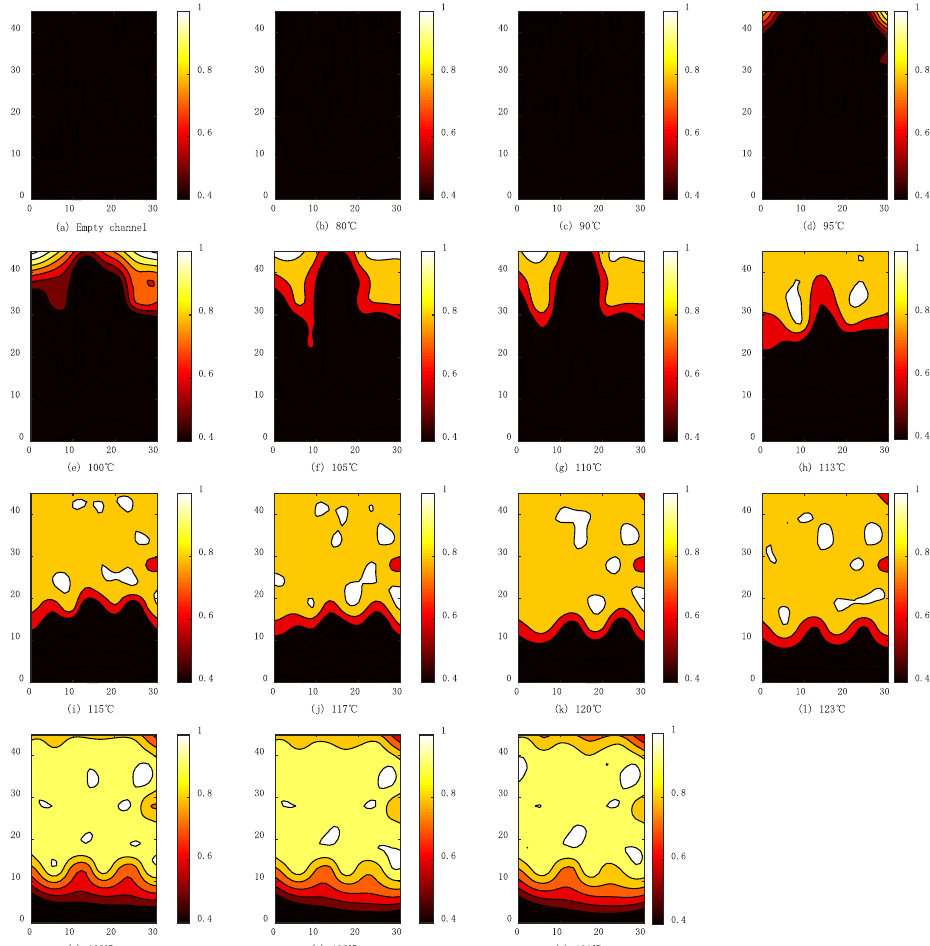
Figure 13. Visualization of the flow boiling in PFHE with different heating temperatures: ( a ) Empty channel; ( b ) 80; ( c ) 90; ( d ) 95; ( e ) 100; ( f ) 105; ( g ) 110; ( h ) 113; ( i ) 115; ( j ) 117; ( k ) 120; ( l ) 123; ( m ) 125; ( n ) 127; ( o )